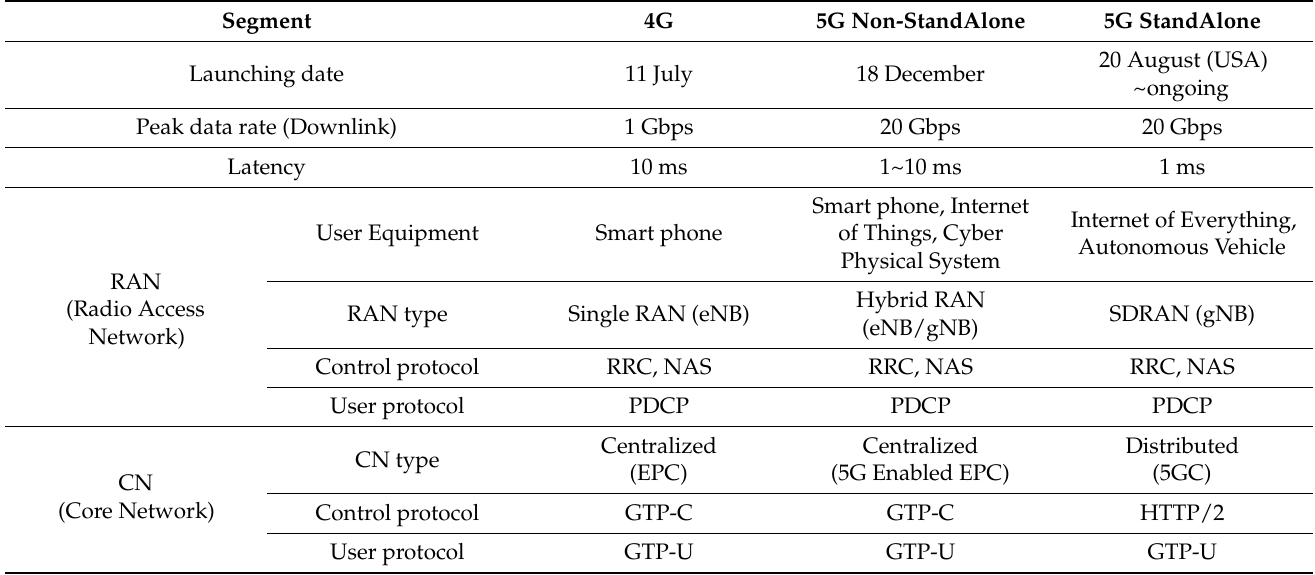
Table 2. 4G and 5G mobile technologies comparison